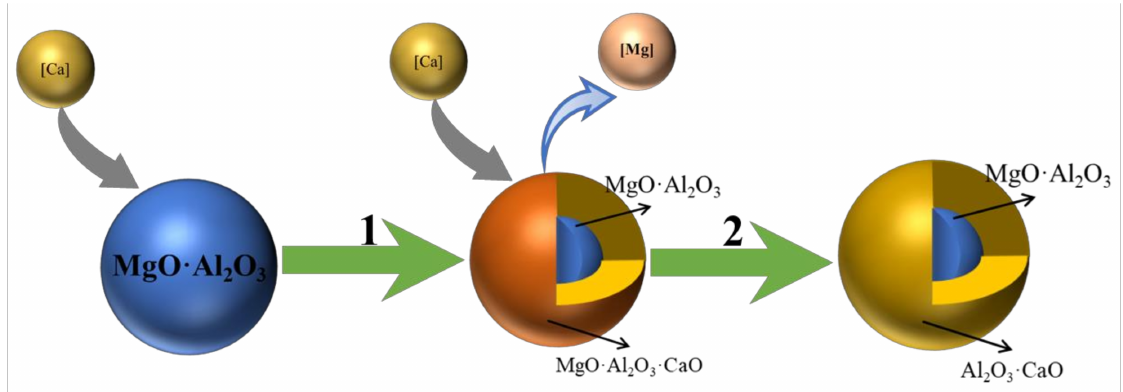
Figure 9. The modification of MgO-Al 2 O 3 complex non-metallic inclusions in steel by calcium treatment. In Figure 9, each type of inclusion is assumed to be spherical. Ca in the molten steel is transferred to the surface of MgO-Al 2 O 3 spinel and reacts with it as shown in Process 1 in Figure 9. The reaction process is expressed by formula (12). In this process, Ca reacts with MgO-Al 2 O 3 spinel surface to form a complex inclusion outer layer of CaO-MgO-Al 2 O 3 . Mg from the reaction is transferred to the molten